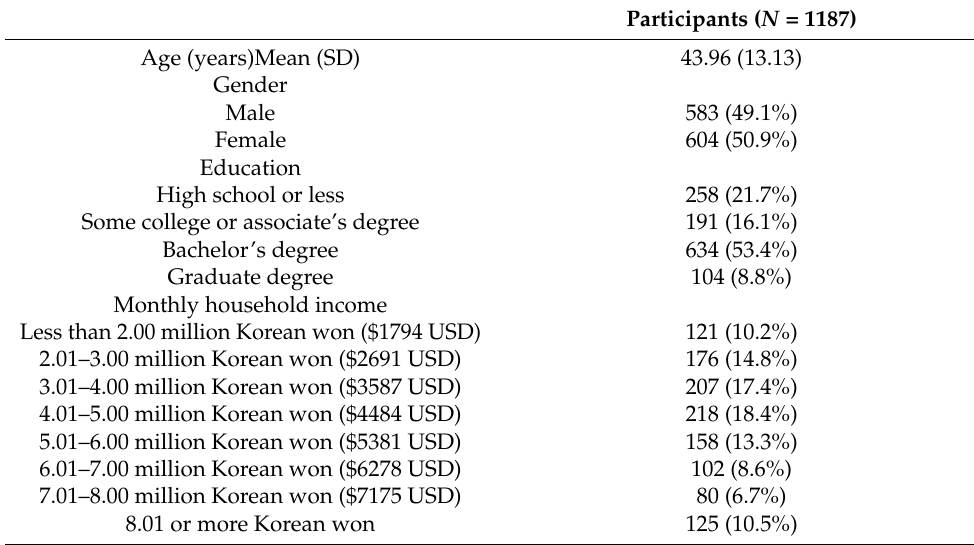
Table 1. Descriptive statistics of study participants.